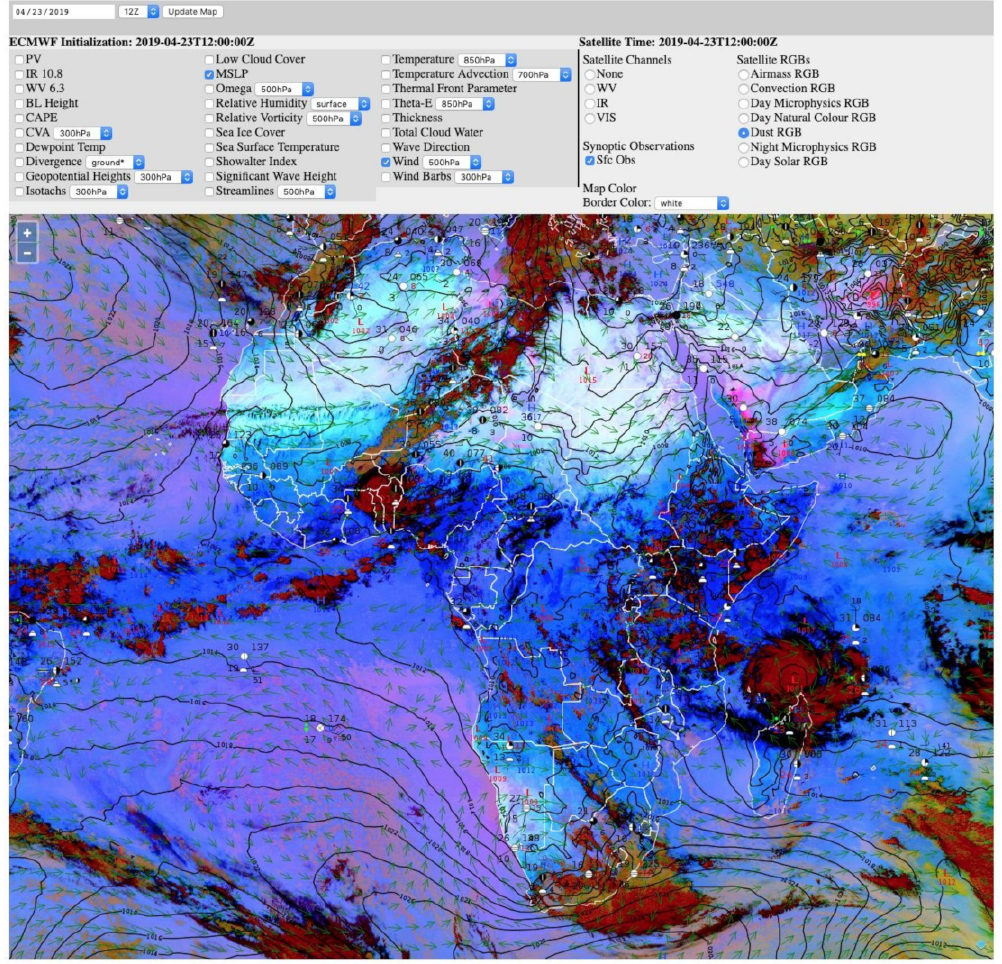
Figure 5. Learners can plot forecast model products and real-time satellite data using web map services enabled within a lesson to look at conditions for a weather situation in their region of interest (https: // www.meted.ucar.edu / asmet / asmet11 /